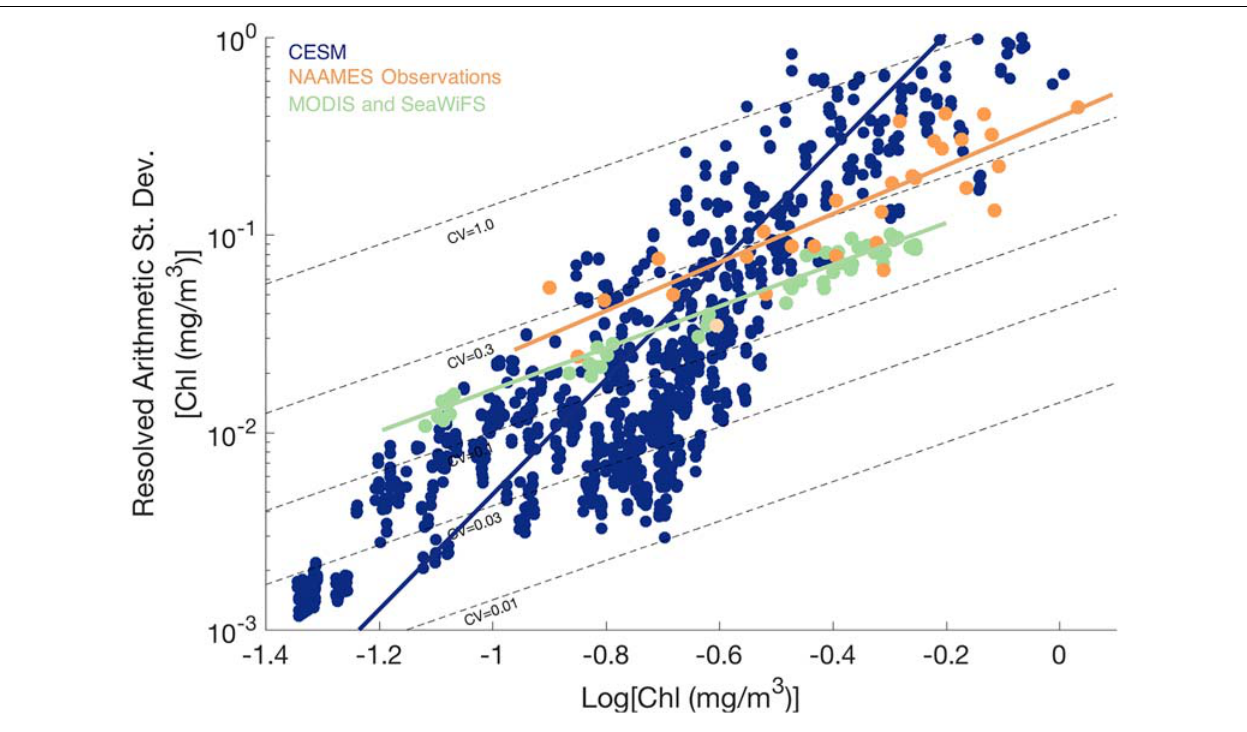
FIGURE 5 | Resolved arithmetic standard deviation of surface chlorophyll a variability against Log 10 surface chlorophyll a concentration for CESM (blue), field observations from NAAMES underway ship data (orange), and MODIS and SeaWiFS satellite ocean color (green) over study region in the western North Atlantic. Dotted lines indicate lines of constant coefficient of variation